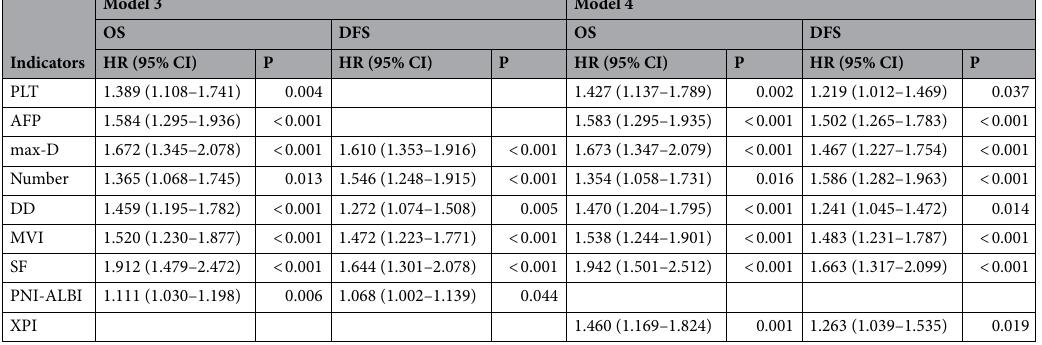
Table 5. Prognostic models for DFS and OS by Cox multivariate regression analysis (Model 3: variables that were independent risk factors of PNI-ALBI were included; Model 4: variables that were independent risk factors of XPI were